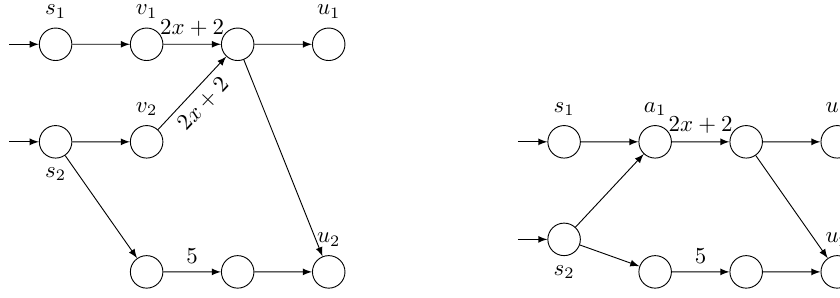
Figure 1. The CON-NG